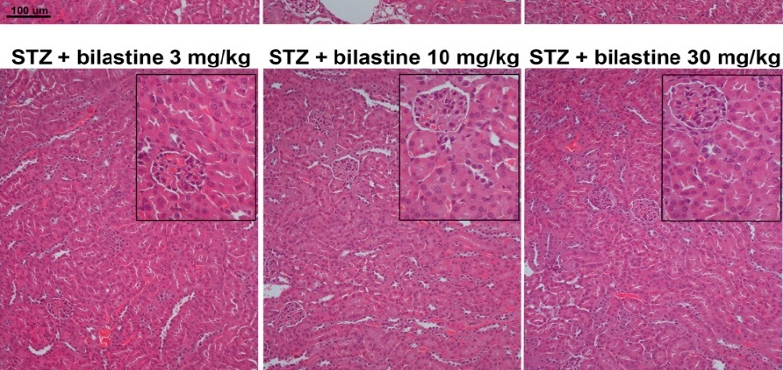
Figure 8. Effect of bilastine on tubular interstitial infiltration. Hematoxylin and eosin staining from renal sections. Arrows highlight infiltrating cells. Micrographs at 20× or 40× (insert) magnification are representative of 10 animals/group.